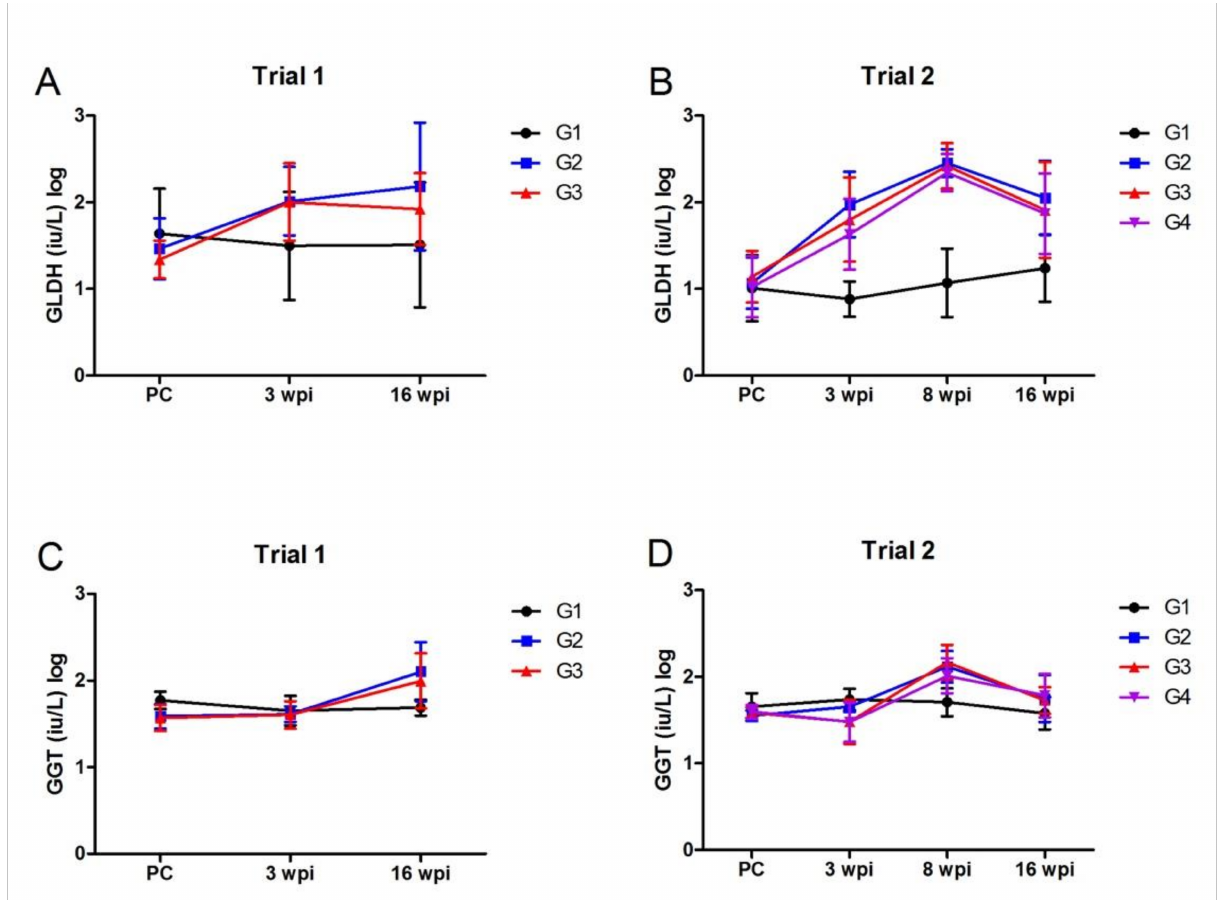
Figure 3. Profile of liver enzymes during F. hepatica infection. ( A , B ) Level of glutamate dehydrogenase (GLDH; units/L) in serum during the vaccine trial time-course presented on a log scale. ( A ) In Trial 1, serum samples were analysed at post-vaccination/pre-challenge with F. hepatica metacercariae (PC), 3 wpi and 16 wpi time-points. ( B ) In Trial 2, serum samples were analysed at post-vaccination/pre- challenge with F. hepatica metacercariae (PC), 3 wpi, 8 wpi and 16 wpi time-points. ( C , D ) Level of gamma glutamyl-transferase (GGT; units/L) in serum during the vaccine trial time-course presented on a log scale. ( C ) In Trial 1, serum samples were analysed at post-vaccination/pre-challenge with F. hepatica metacercariae (PC), 3 wpi and 16 wpi time-points. ( D ) In Trial 2, serum samples were analysed at post-vaccination/pre-challenge with F. hepatica metacercariae (PC), 3 wpi, 8 wpi and 16 wpi time-points. Data represented at ± standard deviation. G1, control unvaccinated, uninfected; G2, control unvaccinated, infected; G3 and G4, vaccinated,